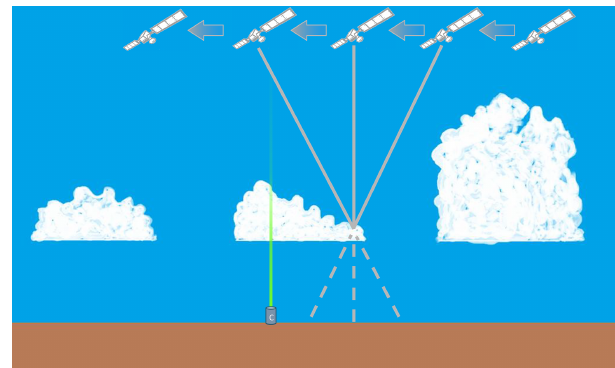
Figure 1. Schematic depiction of a cloud field observed from differ- ent viewing angles during the satellite overpass. Ceilometers, here represented as a cylindrical box, provide ground-based measure- ments of cloud base heights which can be used as a